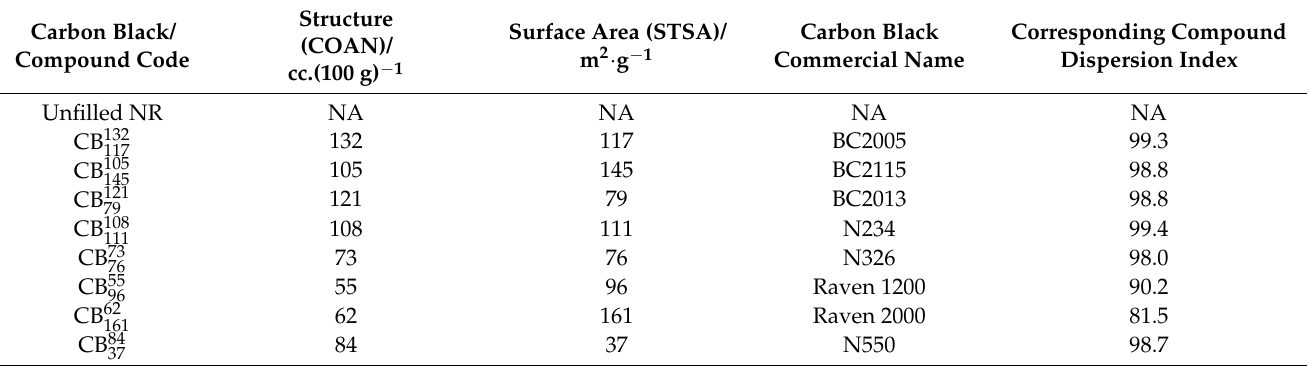
Table 2. CB structure and surface area; CB naming convention adopted in this paper; compounds and compound dispersion